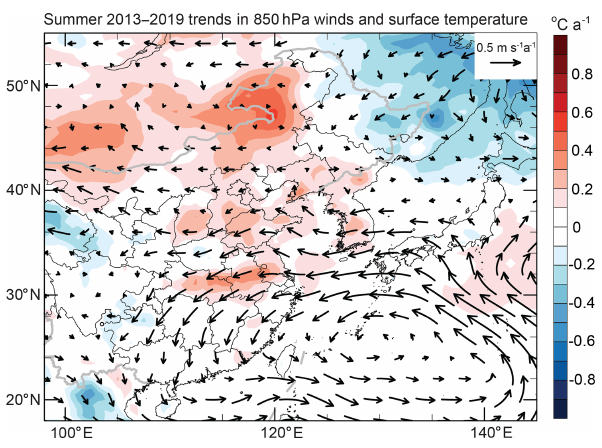
Figure 4. Time series of JJA daily maximum surface air tempera- tures over the North China Plain (NCP) for 1980–2019. Values are monthly means from the MERRA-2 reanalysis. The 2013–2019 pe- riod for the ozone trend analysis is shaded in